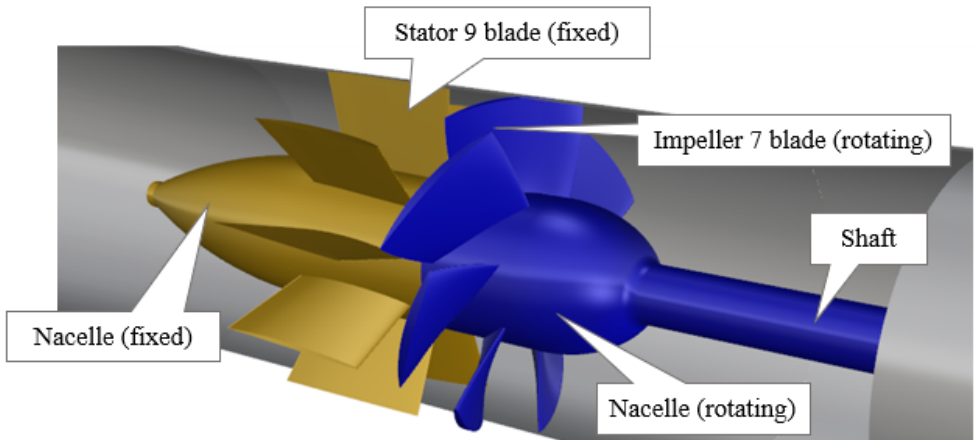
Figure 2. Impeller and stator geometry.